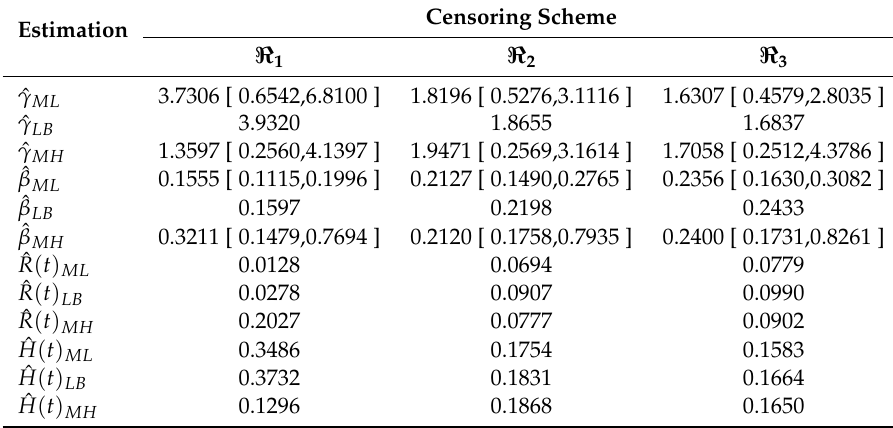
Table 25. Maximum Likelihood and Bayesian Estimates under different